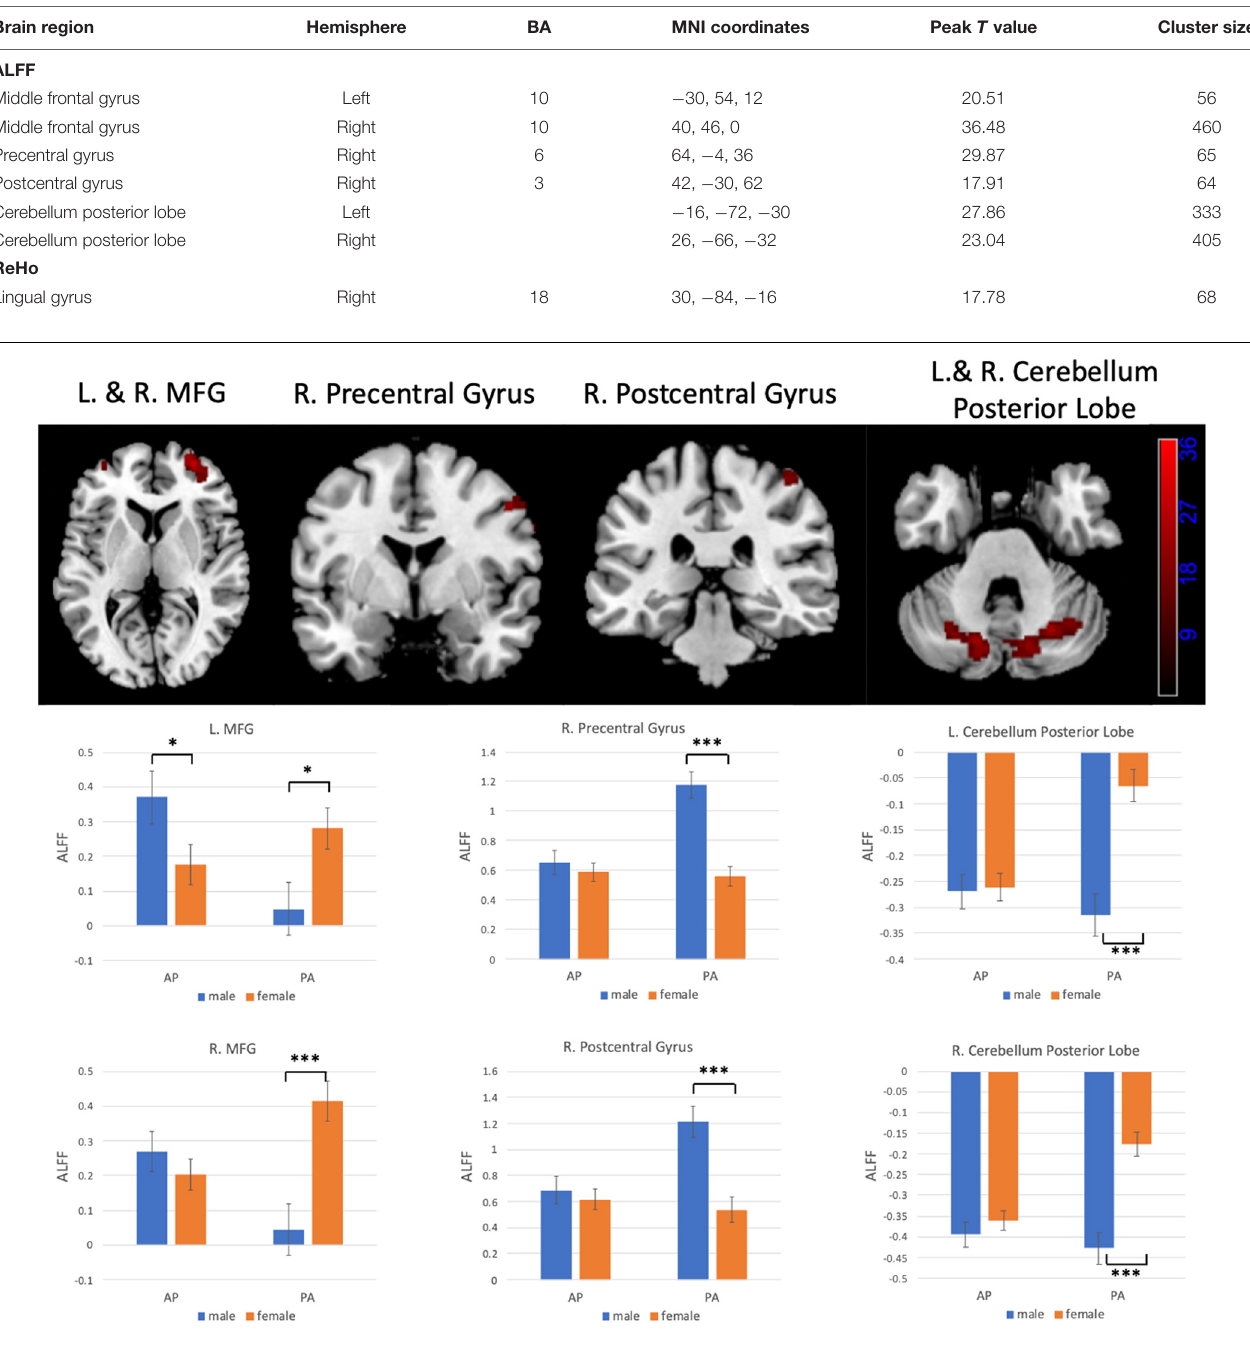
FIGURE 6 | Regions influenced by the interaction effect between gender and PE direction (AP vs. PA) for ALFF and the results of post hoc analysis. MFG, middle frontal gyrus. ∗ p < 0.05, ∗∗∗ p < 0.001.